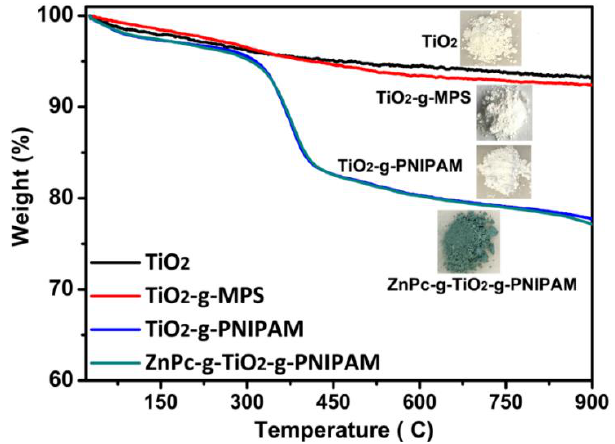
Figure 4. TG curves of TiO 2 , TiO 2 -g- MPS, TiO 2 -g- PNIPAM and ZnPc -g- TiO 2 -g- PNIPAM.